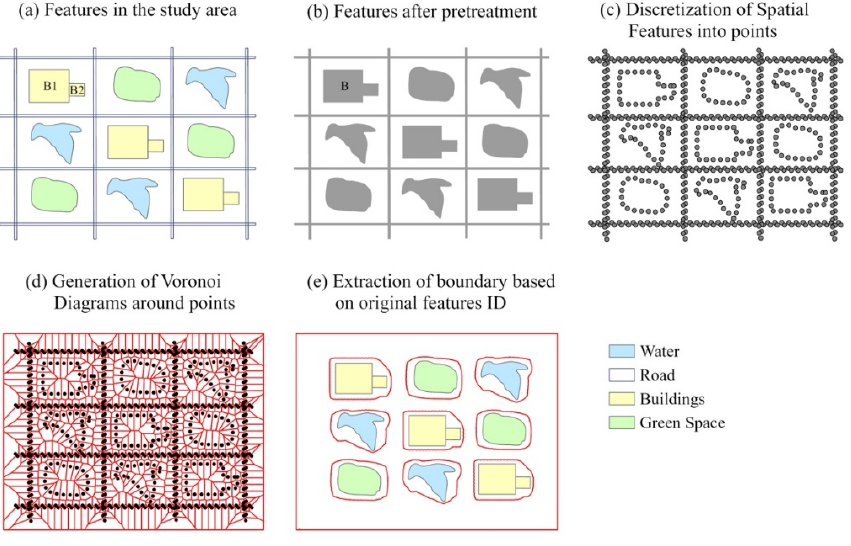
Figure 7. Voronoi diagram for the polygon method.